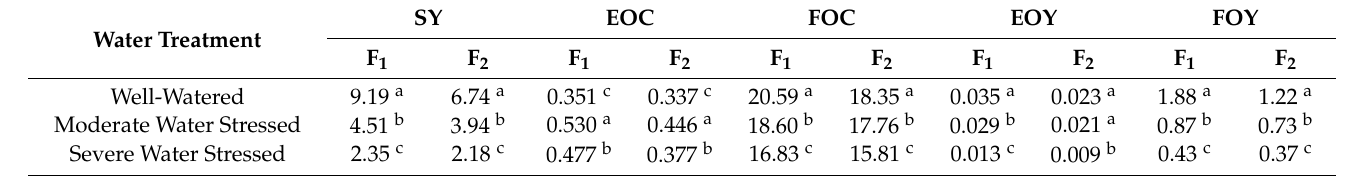
Table 2. The mean of traits under different irrigation treatments in F 1 and F 2 generations of